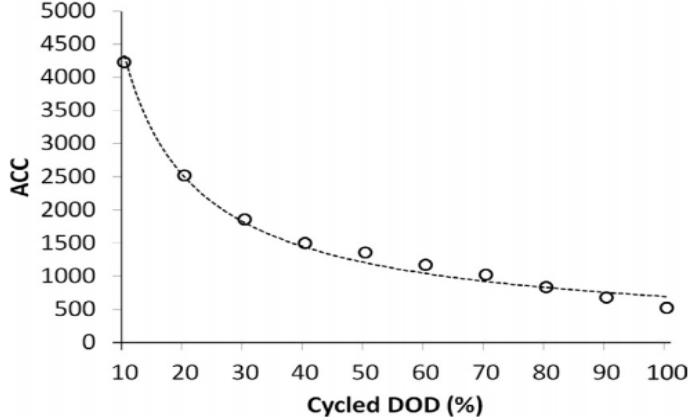
Figure 1. Lithium-ion DOD-ACC model.